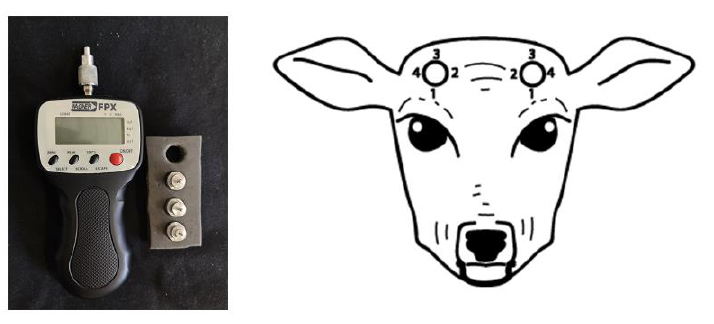
Figure 1. Left: Wagner hand-held algometer (FPX 20) with 2 mm diameter steel probe. Right: Sites of algometer probe placement around the base of the antler to measure nociceptive thresholds. 1 = cranial, 2 = medial, 3 = caudal and 4 = lateral.